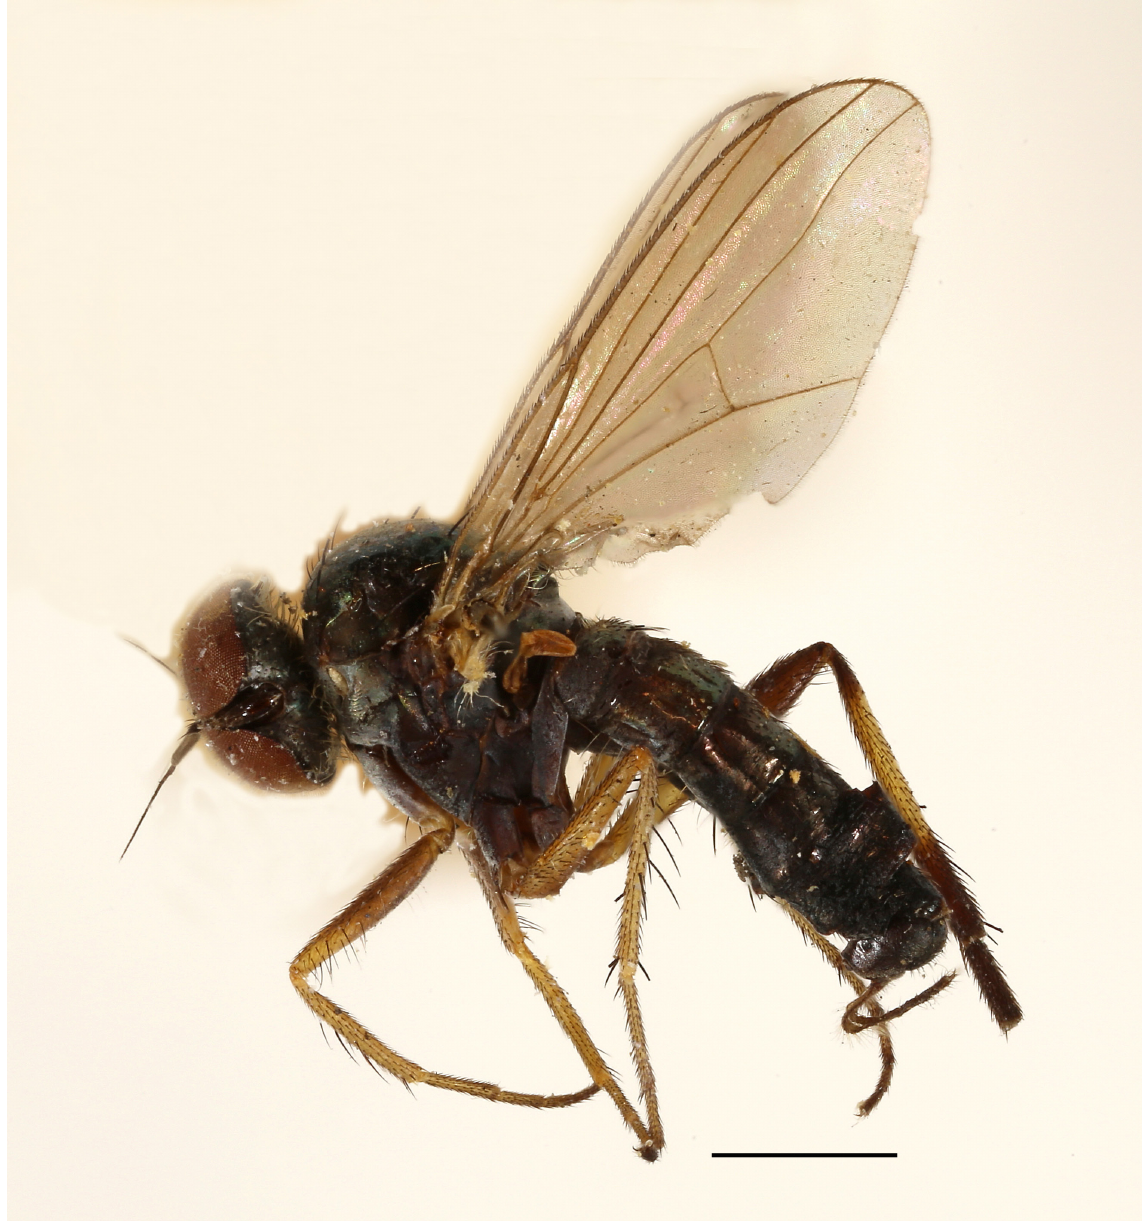
Fig. 8. Rhaphium eburnea (Parent, 1926), lectotype, ♂, habitus (MNHN). (Photo credit Mr Emmanuel Delfosse,